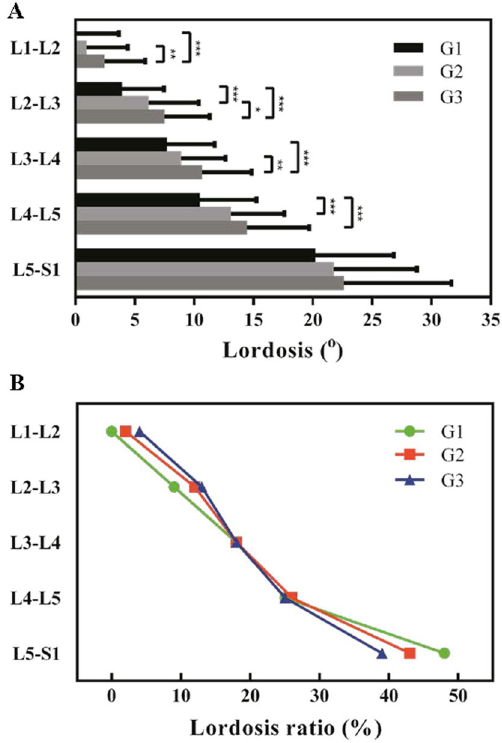
Figure 2. ( A ) Segmental lordosis of pelvic incidence groups in terms of degree. ( B ) Segmental lordosis of pelvic incidence groups in terms of ratio.